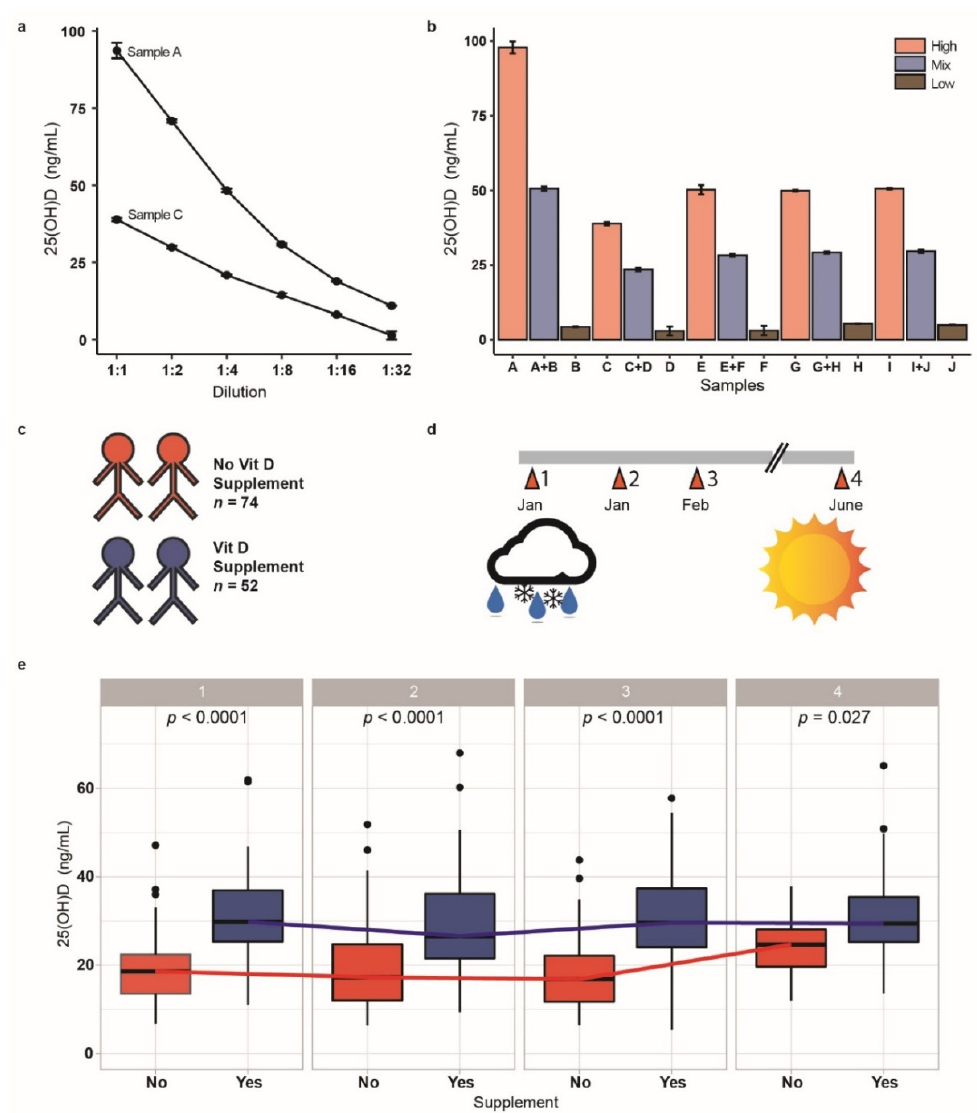
Figure 3. Vitamin D assessment and change of Vitamin D status according to supplement use over 24 weeks. ( a ) Vitamin D status was assessed as 25(OH)D concentrations. Two samples with high 25(OH)D were tested in dilution experiments and showed linear signal decline with dilution. ( b ) Ten serum samples (5 high and 5 very low) were mixed equally (1:1, v/v) to test for matrix interference, and the test yielded the predicted 25(OH)D concentrations. ( c ) Among the 126 participants included at baseline, 52 took vitamin D supplements. ( d ) The study started in winter and extended into summer. ( e ) Vitamin D status of participants supplementing or not supplementing vitamin D were compared at each sampling time point. Participants who supplemented vitamin D had higher 25(OH)D concentrations at each time point. For the first three samplings, this difference was remarkable (January, February; p < 0.0001), but became less prominent in summer (June; p = 0.027).